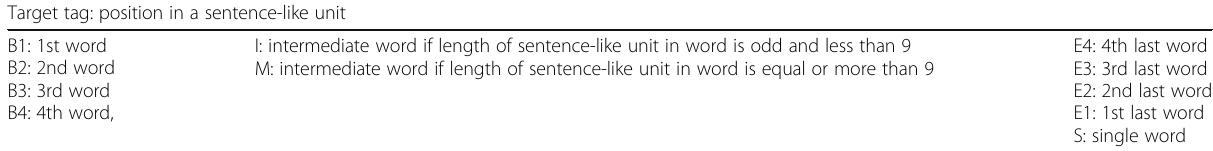
Table 6 Targets for iPCst Target tag: position in a sentence-like